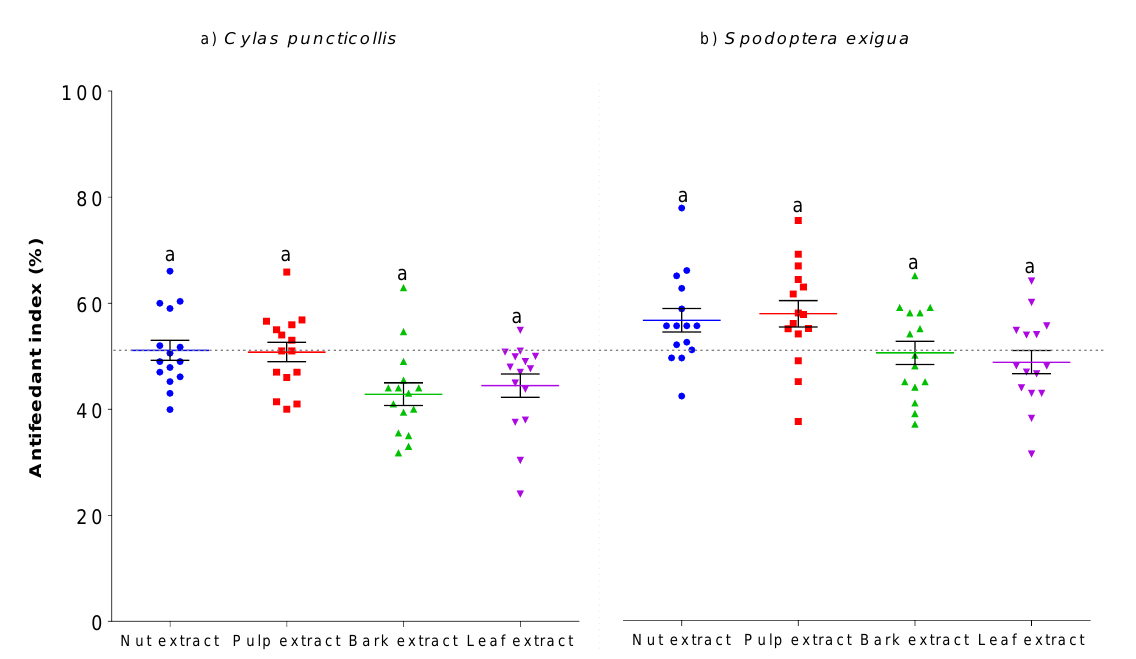
Figure 1. Scatter plot representation of antifeedant index at 2% concentration of crude extracts from various parts of M. volkensii ± standard error of mean (SEM) with 5 technical repeats and 3 independent biological repeats per plant part against C. puncticollis ( a ) and S. exigua ( b ). Means followed by same letter indicate no significant difference after Bonferroni correction (see Section 2.6). Same letter ‘a’ means that there is no significant difference in antifeedant activity between the different treatments.